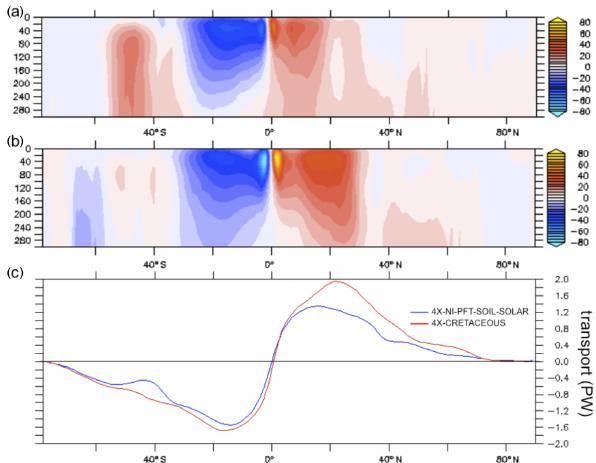
Figure 8. (a, b) Global mean annual meridional stream-function (Sv) for the first 300m of water depth. Red and blue colours indicate clockwise and anticlockwise circulation respectively. (a) 4X-NI- PFT-SOIL-SOLAR and (b) 4X-CRETACEOUS. (c) Oceanic heat transport for 4X-NI-PFT-SOIL-SOLAR and 4X-CRETACEOUS simulations. Positive and negative values indicate northward and southward transport direction